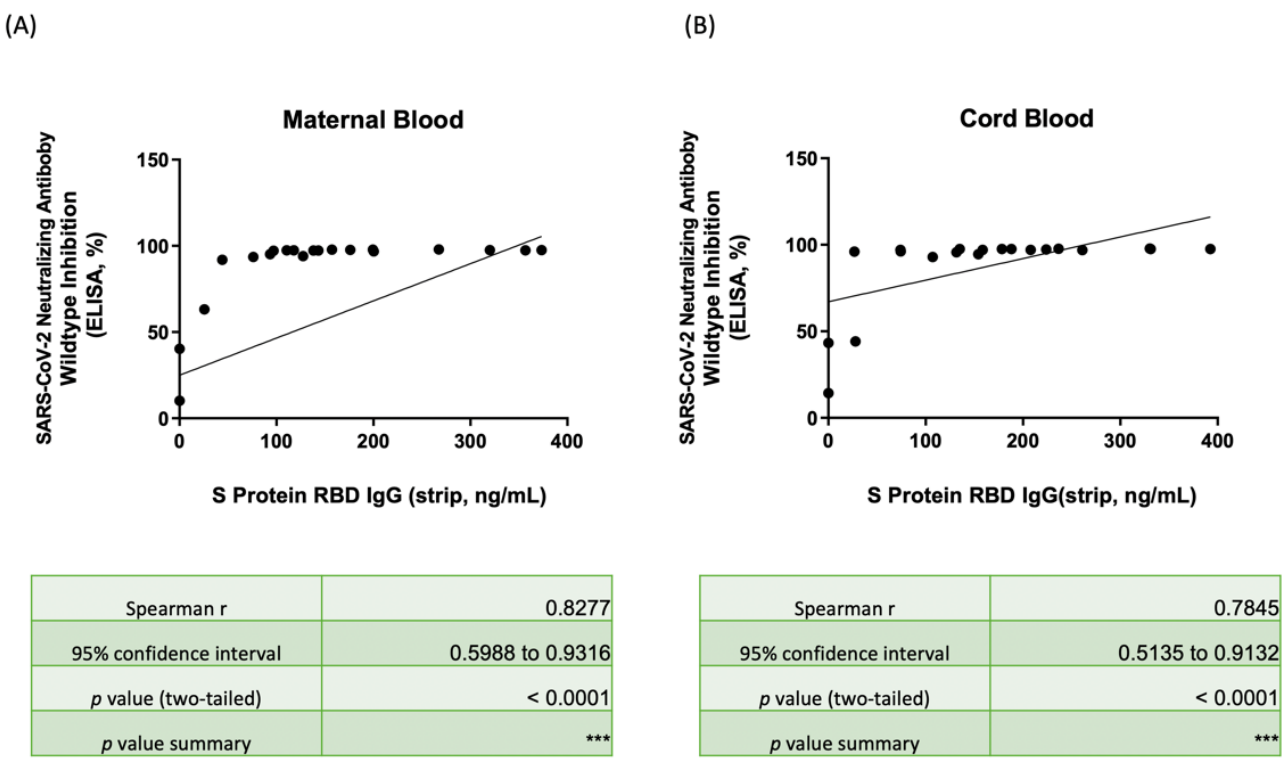
Figure 3. ( A ) Scatter plot showing the correlation between SRBD IgG by the lateral flow immunoas- say/spectrum analyzer and the neutralizing antibody inhibition rates against wild-type SARS-CoV-2 by ELISA in maternal serum. ( B ) Scatter plot showing the correlation between SRBD IgG by the lateral flow immunoassay/spectrum analyzer and the neutralizing antibody inhibition rates against wild-type SARS-CoV-2 by ELISA in neonatal cord blood. SRBD, spike protein receptor binding do- main; ELISA, enzyme-linked immunosorbent assay. *** p < 0.001.